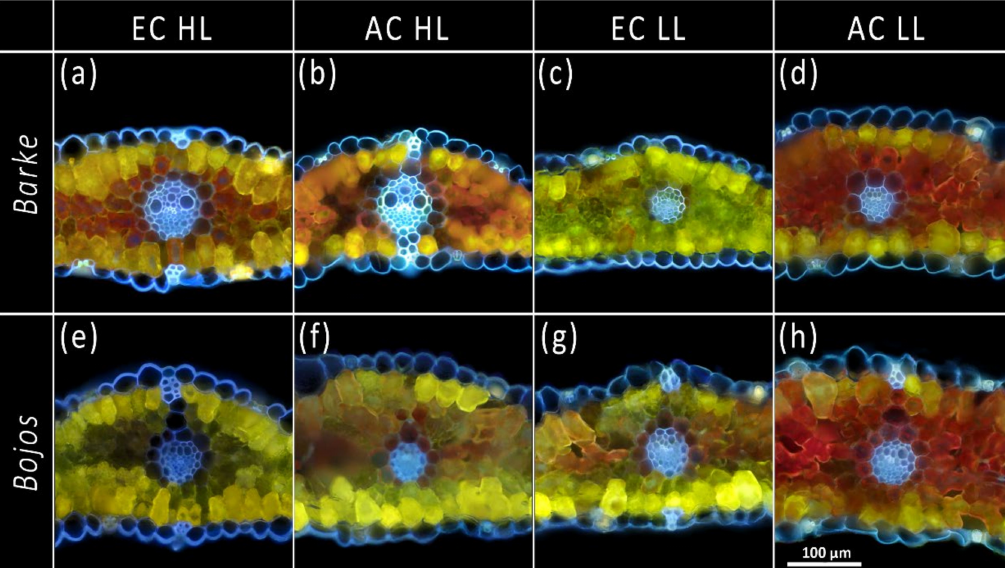
Figure 3. Cross-sections of barley ( Hordeum vulgare) leaves showing the strong presence of flavonoids in the mesophyll, especially close to leaf surfaces, and the absence of flavonoids in the epidermal pavement cells, 100 × magnification, treated with Naturstoff reagent A and acquired under UV light. Epidermal pavement cells exhibit blue fluorescence mainly from outer cell walls, but not from intracellular compartments. Strong yellow fluorescence indicates the presence of flavonoids in mesophyll layers adjacent to both epidermises, with reduced intensity towards the internal leaf tissue. The effect of elevated [CO 2 ] on flavonoid accumulation even in the absence of high light is illustrated in ( c , g ). Barke ( a ) AC-LL; ( b ) EC-LL; ( c ) AC-HL; ( d ) EC-HL. Bojos ( e ) AC-LL; ( f ) EC-LL; ( g ) AC-HL; ( h ) EC-HL. (Abbreviations are AC-ambient [CO 2 ], EC-elevated [CO 2 ], HL–high light, LL–low light.). Table 1. Results of four-way ANOVA on the effects of barley variety (Var), CO 2 concentration ([CO 2 ]), light intensity (Light), and tissue localization (Loc) in leaf cross-sections, and their mutual interactions ( × ) on fluorescence intensity emitted by phenolic compounds enhanced with Naturstoff reagent A showing localization of within leaf cross-sections. Degrees of freedom ( df ), F and p values shown for each factor and interaction. Significant effects ( p < 0.05) are indicated in bold.